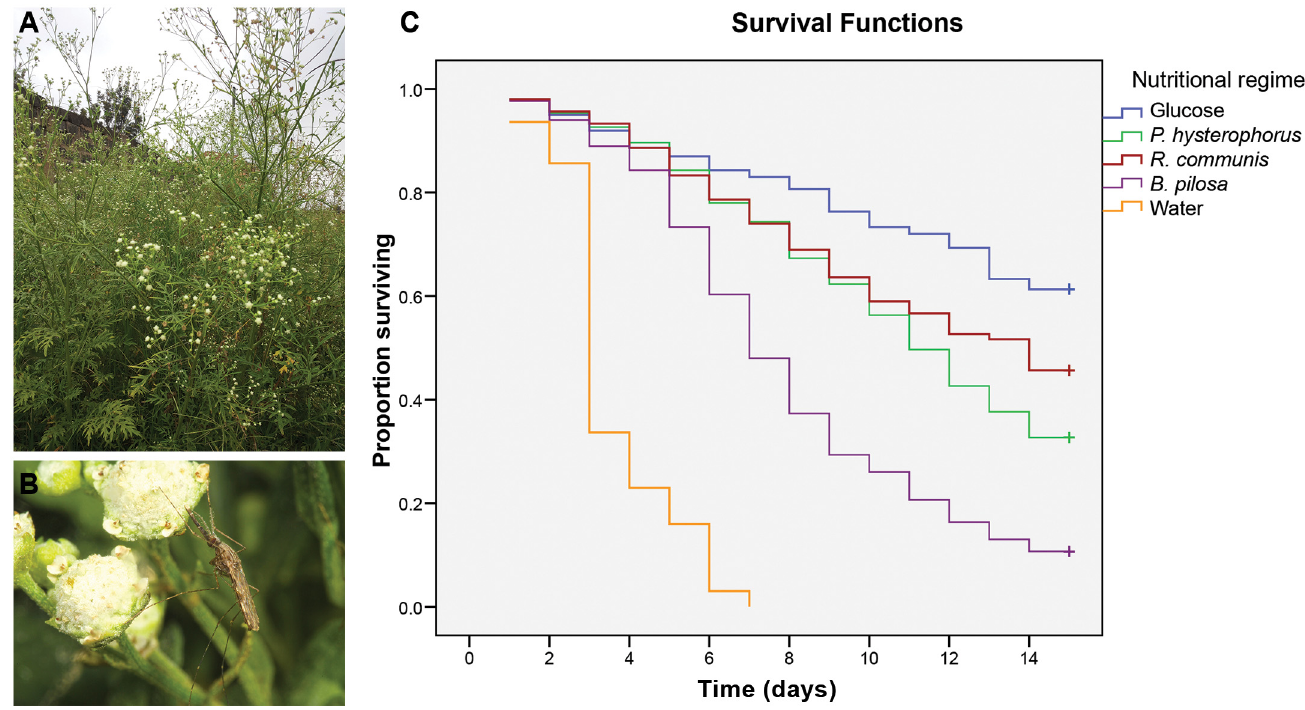
Fig 1. Probing and survival on intact plant. A) Invasive weed, Parthenium hysterophorus , B) Female Anopheles gambiae probing on the flowers of P . hysterophorus , and C) Proportion of female An . gambiae surviving after exposure to different nutritional regimes. Glucose solution (6%) and water were used as positive and negative controls, respectively. The surviving mosquitoes from each treatment were censored on day 15 (survival curves marked + symbol).